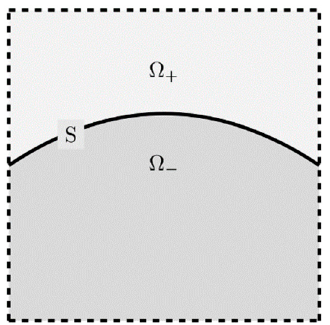
Figure 1. Phase Figure 1. Phase transition.